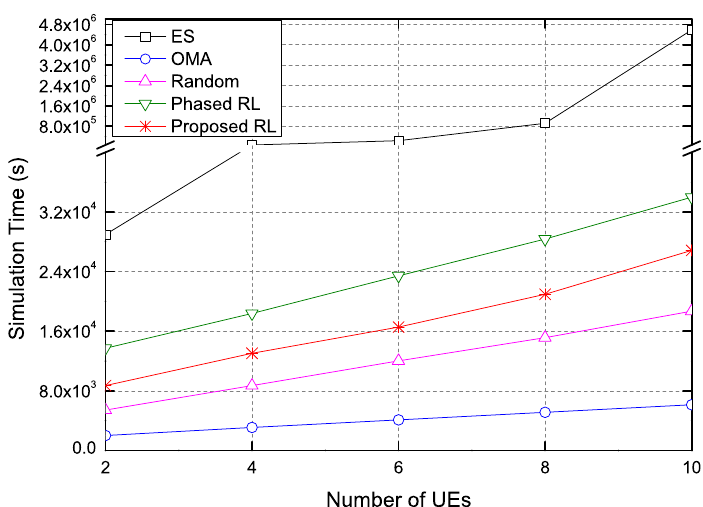
Figure 8. Sum rate versus the number of UEs.